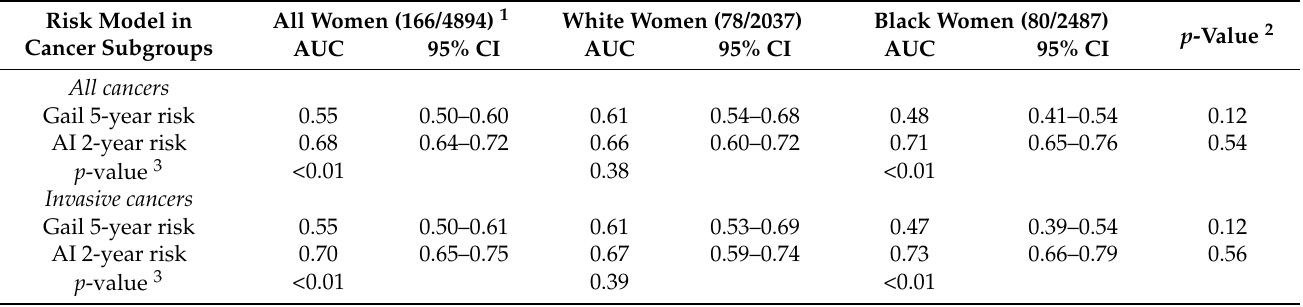
Table 4. Discriminatory performance (AUC) in women with available Gail risk factors, in the full cohort and in racial subgroups, for any breast cancer subtype and for invasive breast cancer.